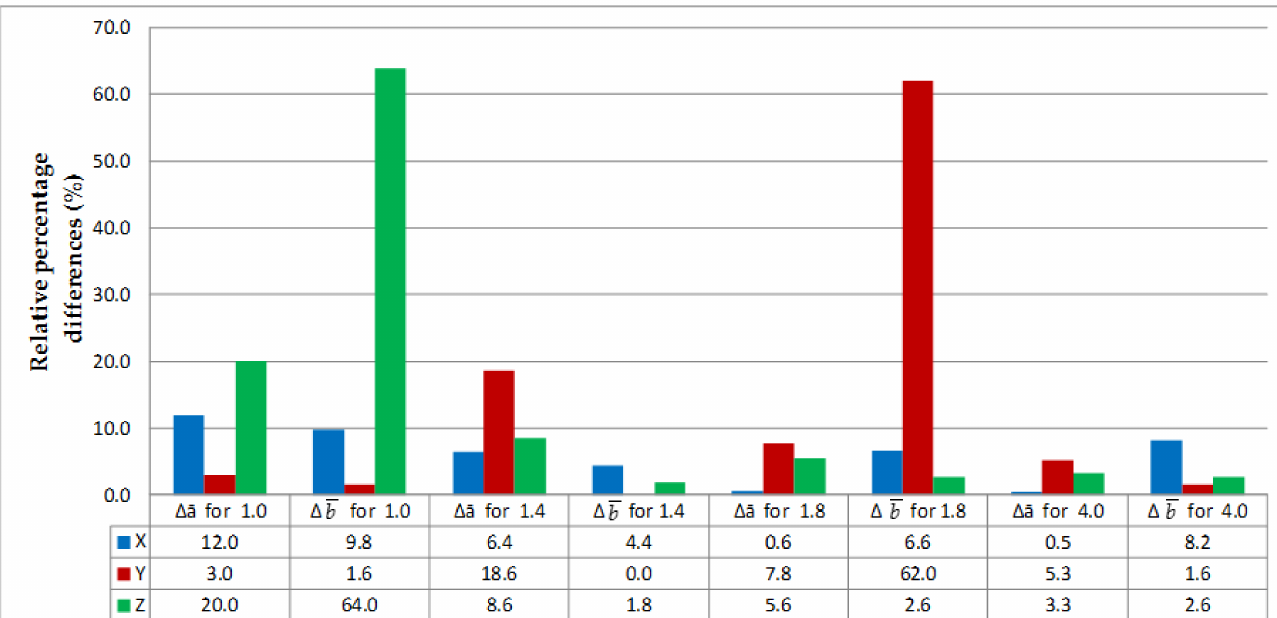
Figure 22. Relative differences in thickness and width between the PLA-CF specimens, where X, Y and Z are printing directions.